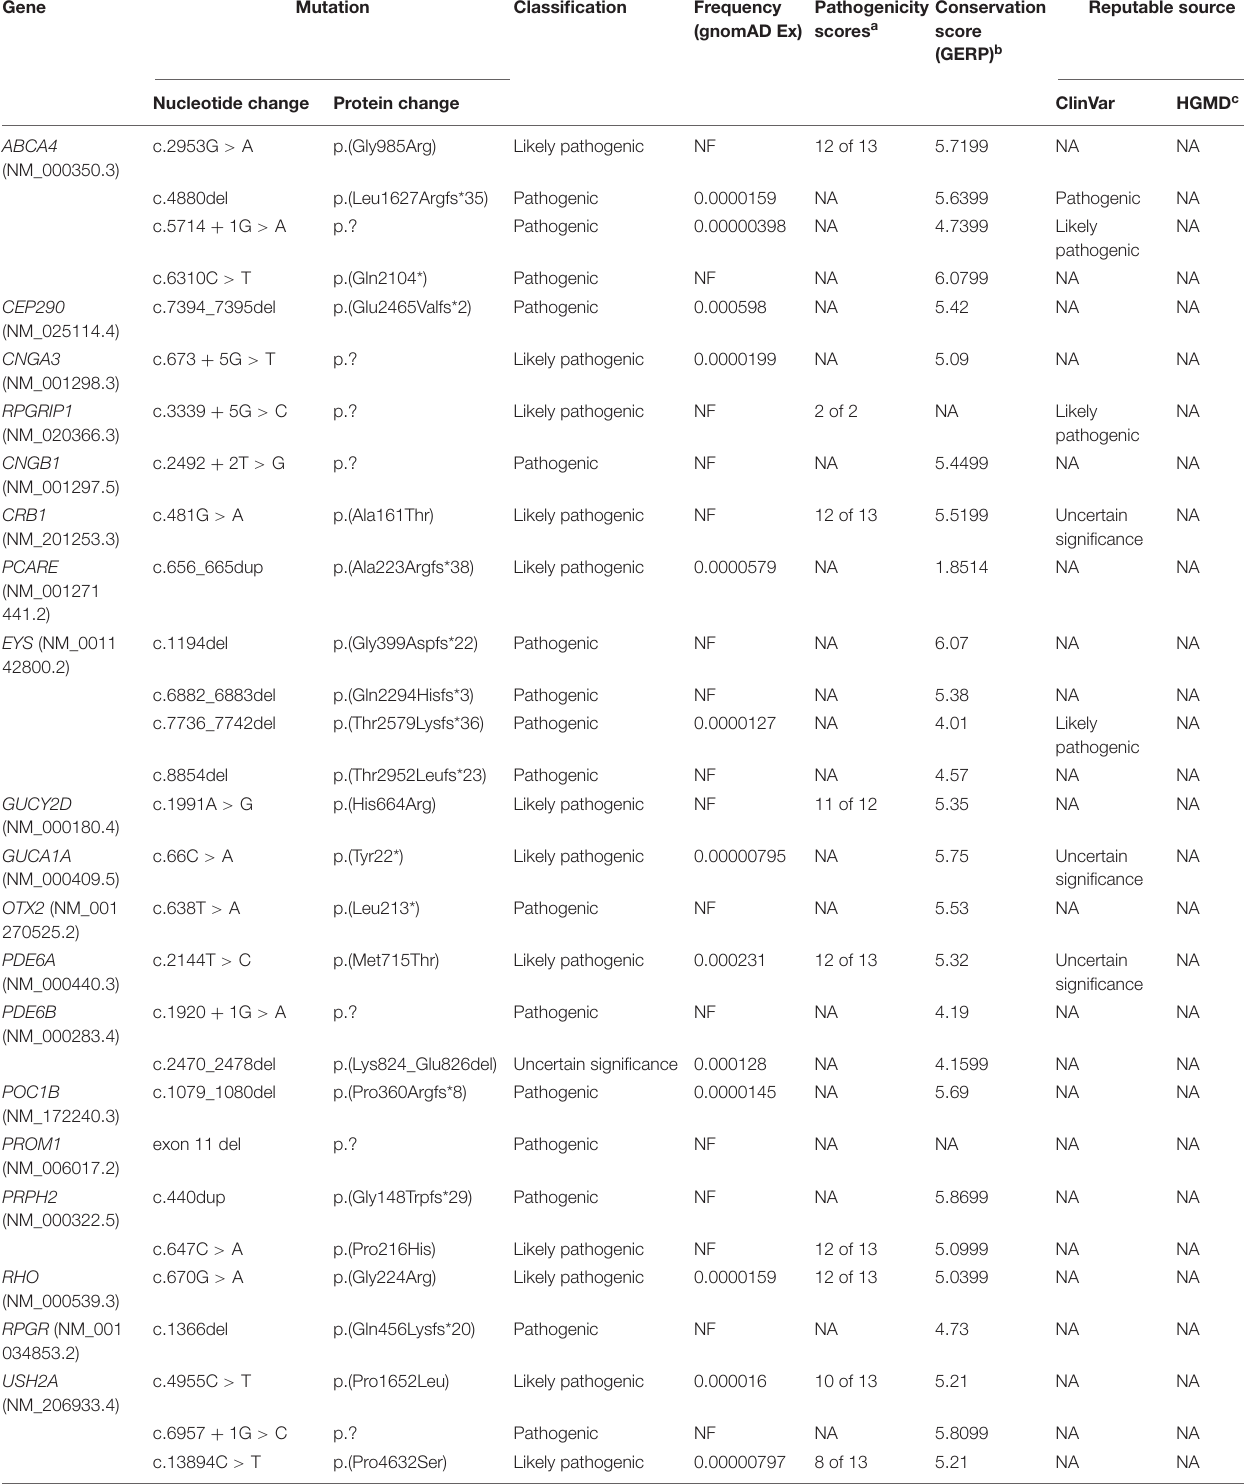
TABLE 3 | Criteria considered for the pathogenicity classification of the novel identified variants. Gene Mutation Classification Frequency